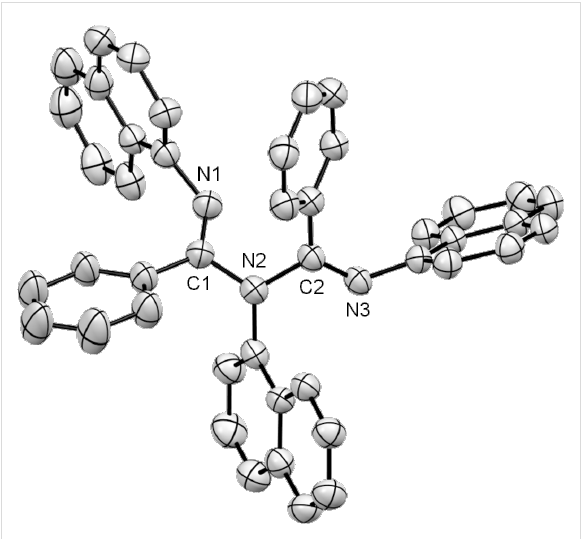
Figure 3: ORTEP drawing of 3b . Thermal ellipsoids are set at 35% probability level. Hydrogen atoms are omitted for clarity. Selected